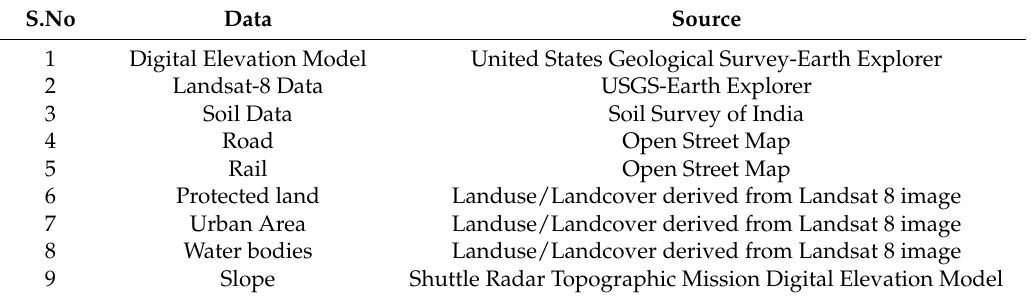
Table 1. Source of data used in site suitability